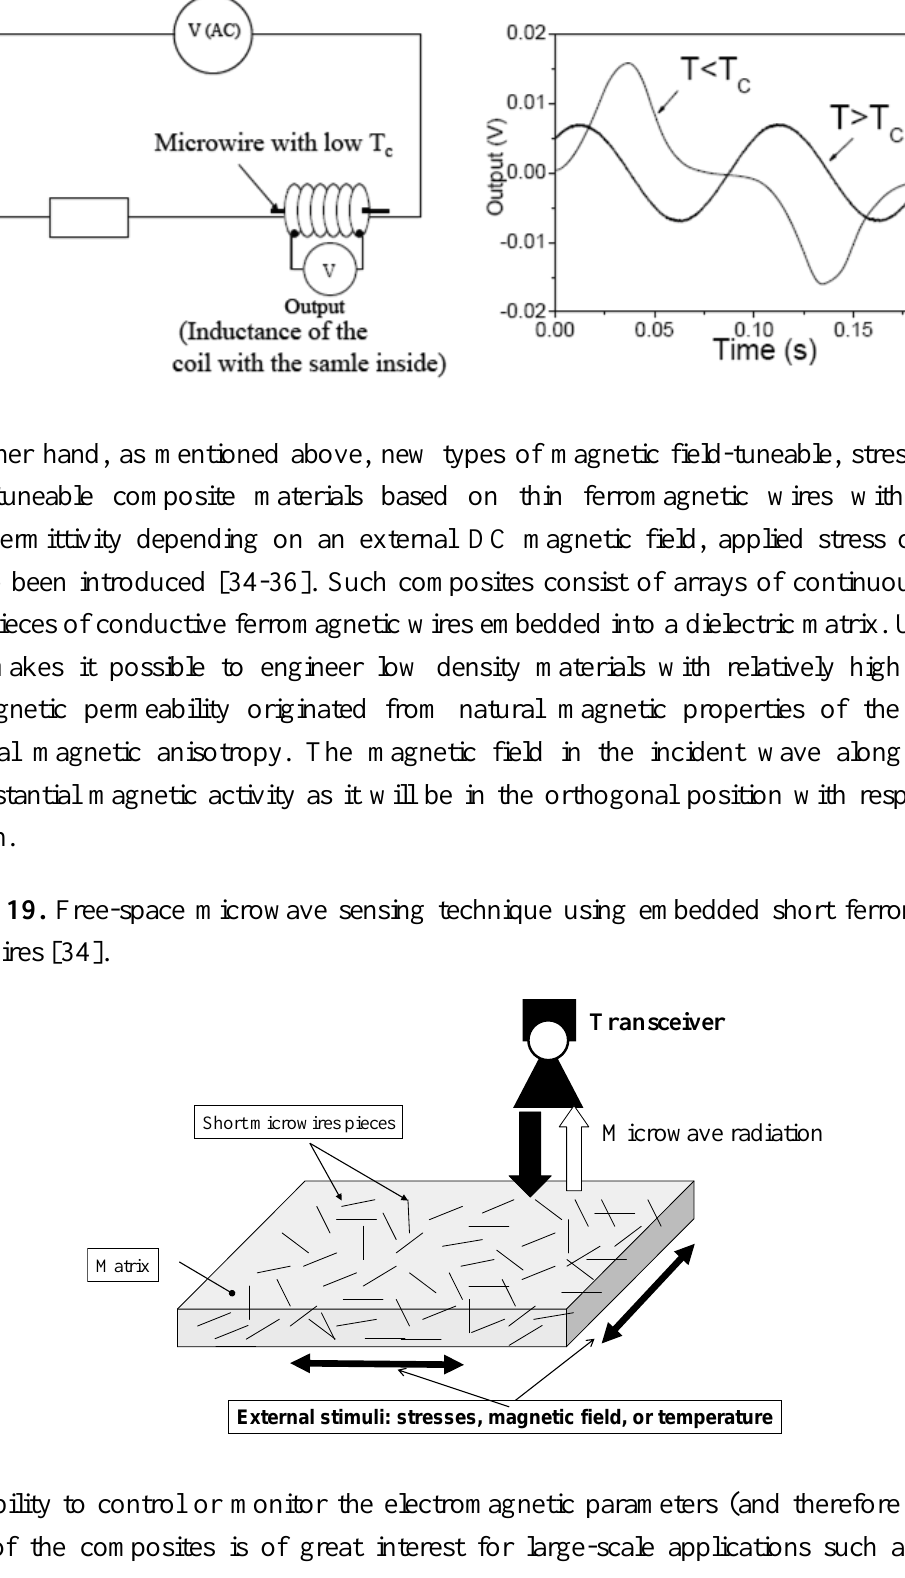
Figure 18. Schematic picture showing the working of the temperature sensor based on change of the inductance in microwires with low T